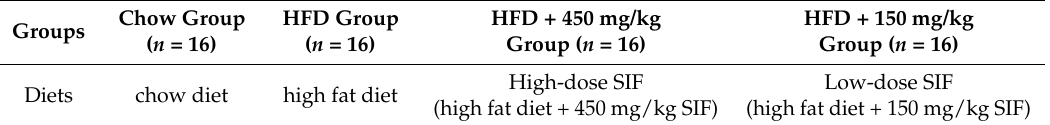
Table 3. Composition of the experimental diets from week nine to week thirteen.